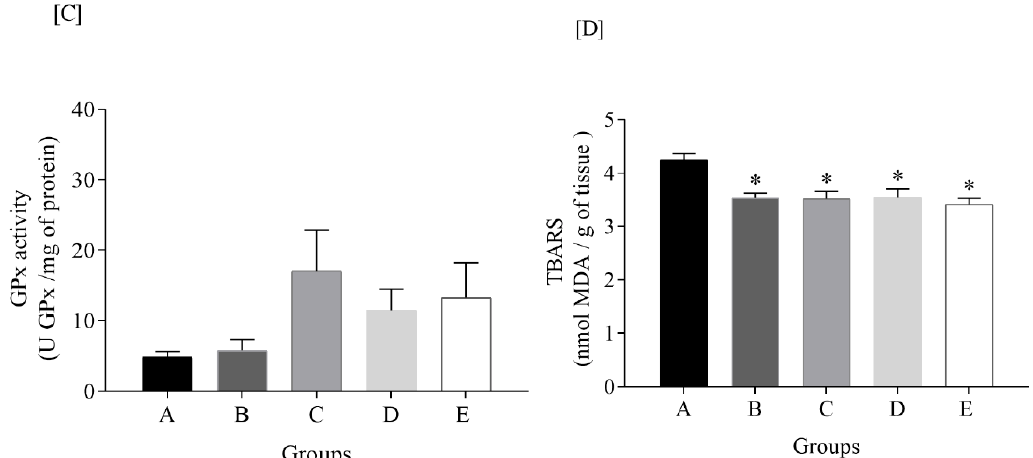
Figure 4. Oxidative status markers in the liver of silver catfish ( Rhamdia quelen ) fed with diets containing different concentrations of Cinnamomum cassia essential oil (CCEO) for 30 days ( A – D ). Letters of the bars: (A) Control diet; (B) supplementation of 0.25 mL of CCEO per kg of diet; (C) supplementation of 0.5 mL of CCEO per kg of diet; (D) supplementation of 1 mL of CCEO per kg of diet; (E) supplementation of 2 mL of CCEO per kg of diet. SOD: superoxide dismutase; GST: glutathione S-transferase; GPx: glutathione peroxidase; TBARS: thiobarbituric acid reactive species. Values are expressed as the mean ± SEM ( n = 8). * Asterisk indicates significant difference from control group (one-way ANOVA and Tukey’s test, p < 0.05).